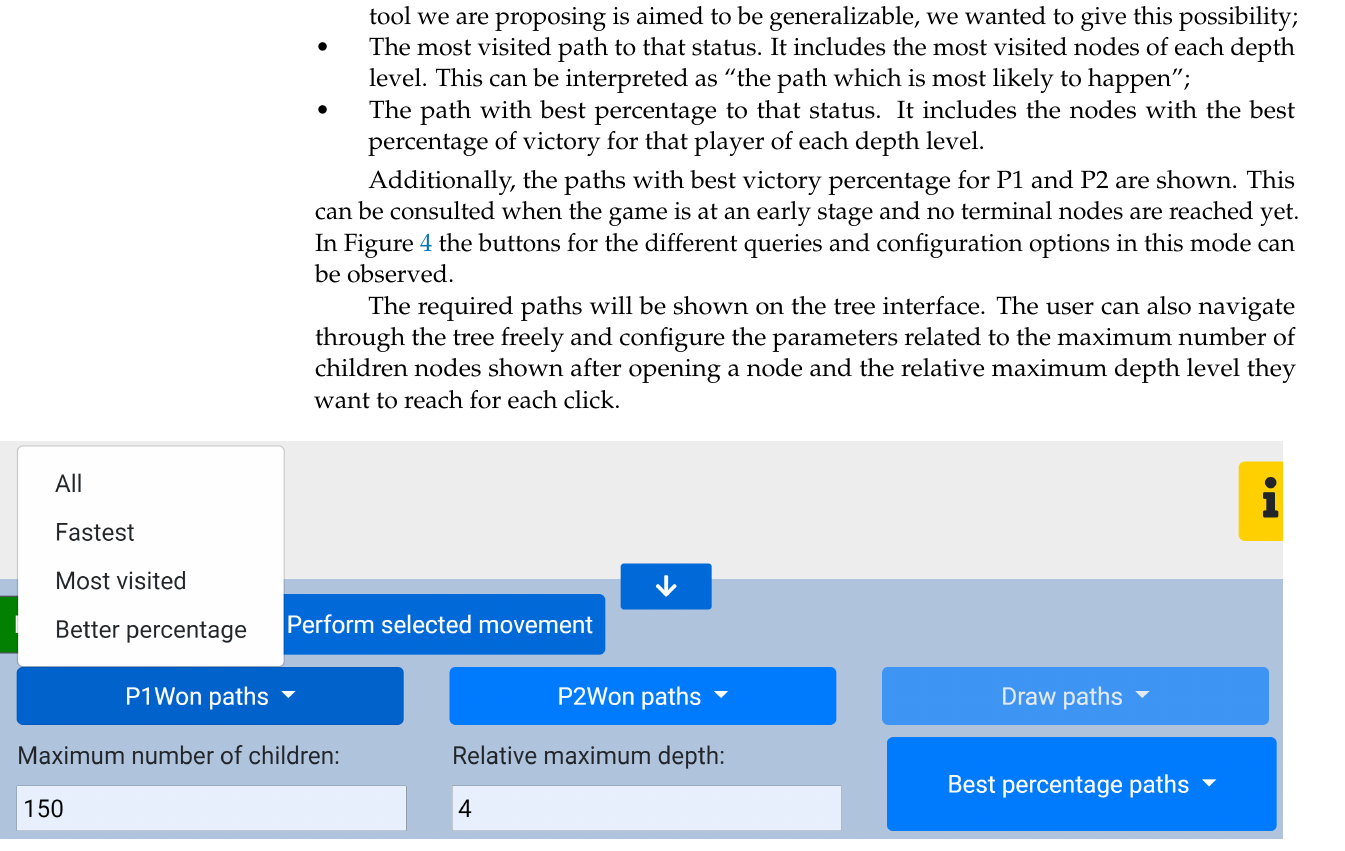
Figure 4. Button panel available at the Expert